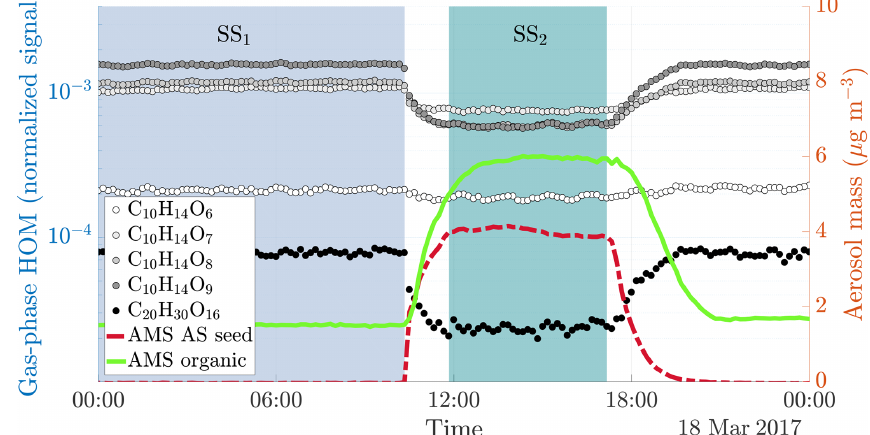
Figure 2. Time series of both gas and particle-phase species during a typical seed injection (experiment 19, Table A1). The experiment starts with only gaseous precursors being injected into the chamber: these form HOMs (dotted lines, measured with the NO − form SOA (solid green line, measured with the AMS). Both the HOMs and the SOA are in a steady state (SS 1 , blue shading). At around 10 o’clock, we start injecting ammonium sulfate seed aerosol (red dashed line). This results in an increased condensation sink, which causes an increase in the SOA mass, and a decrease in the gas-phase HOM signals. After a transition period, a new steady state is reached (SS 2 , turquoise shading). Upon stopping the seed injection, the SOA levels decrease again, and the HOM signals increase.